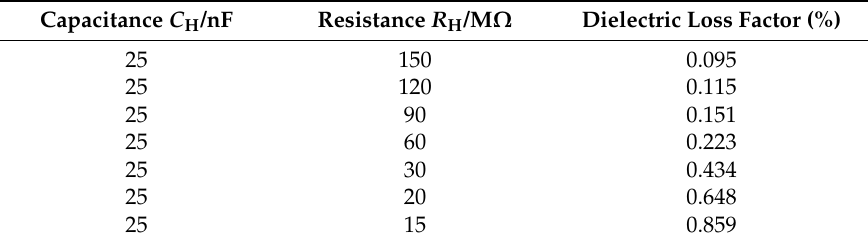
Table 2. Dielectric loss factor of high-voltage capacitor with different resistance. Capacitance C H /nF Resistance R H /M Ω